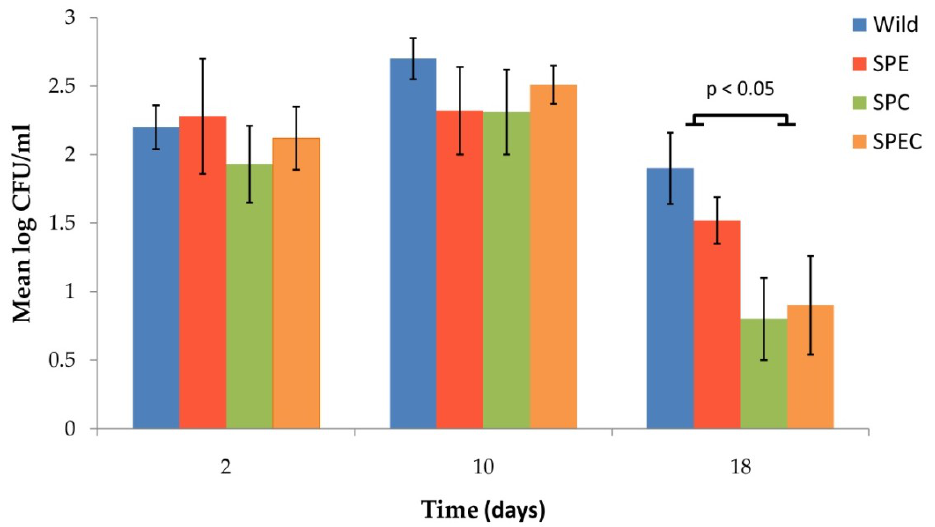
Figure 4. Number of S. pneumoniae cells (presented as log 10 CFU / mL) recovered from the nasopharyngeal wash fluids of BALB / c mice at various time intervals following intranasal inoculation with 1 × 10 7 CFU of the respective bacterial strains. Error bars represent standard deviation (SD). The statistical analysis of nasopharyngeal (NP) colonisation between the groups was performed using analysis of variance (ANOVA) followed by a post-hoc Tukey’s test. Abbreviations used: wild, S. pneumoniae D39 wild-type strain; SPE, S. pneumoniae D39 ( endA::aphA3 ) knockout strain; SPC, S. pneumoniae D39 ( cpsE::tetL ) knockout strain; SPEC, S. pneumoniae D39 ( cpsE::tetL ; endA::aphA3 ) double-knockout strain;